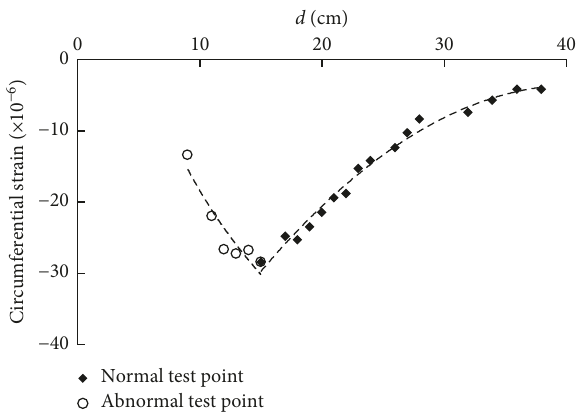
Figure 12: Top surface circumferential strain of the CC model after removing the abnormal points.